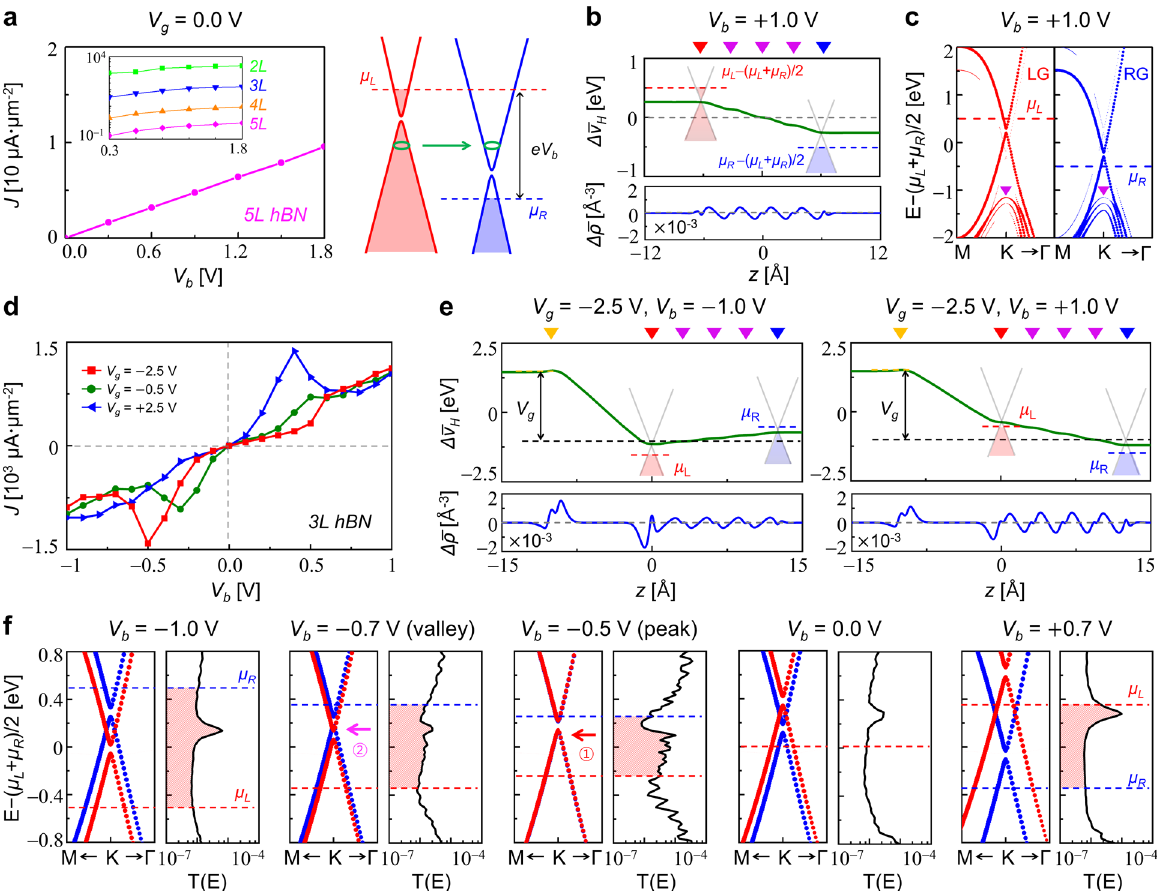
Fig. 2 Gating-induced asymmetric NDR characteristics. a The V g ¼ 0 V current density-bias voltage ( J (cid:2) V b ) characteristic of the left graphene (LG)/5L hBN/right graphene (RG) junction (left panel) and a schematic of the tunneling-based electron transport mechanism (right panel). Inset: The J (cid:2) V b curves for the hBN 2 — 5L cases are shown on a logarithmic scale. b The V g ¼ 0 V Δ v H (upper) and Δ ρ (lower) distributions of the LG/3L hBN/RG junction at V b = 1.0 V. Red, purple, and blue down triangles indicate the positions of LG, hBN, and RG layers, respectively. c The V g ¼ 0 V projected bands of the LG/3L hBN/RG junction at V b = 1.0 V. The circle size is in proportion to the weight of wavefunctions projected to the LG (red) and RG (blue) electrodes. Purple down triangles indicate the projections nearby hBN bands. d Gate- dependent J (cid:2) V b curves of th e LG/3L hBN/RG junction at V g ¼ þ 2 : 5 V (blue), V g ¼ (cid:2) 0 : 5 V (green), and V g ¼ (cid:2) 2 : 5 V (red). e The V g ¼ (cid:2) 2 : 5 V Δ v fi les of the LG/3L hBN/RG junction at V : 0 V (left) and V : 0 V (right). Yellow, red, purple, and blue down triangles indicate H pro b ¼ (cid:2) 1 b ¼ þ 1 the locations of the Au, LG, hBN, and RG layers, respectively. f The V g ¼ (cid:2) 2 : 5 V projected bands (left panels) and T E ; V b ð Þ spectra (right panels) at V b ¼ (cid:2) 1 : 0 V, − 0.7 V (NDR valley), − 0.5 V (NDR peak), 0.0 V, + 0.7 V. The sizes of circles quantify the strength of orbital contributions of different 2D layers to the LG (red) and RG (blue)